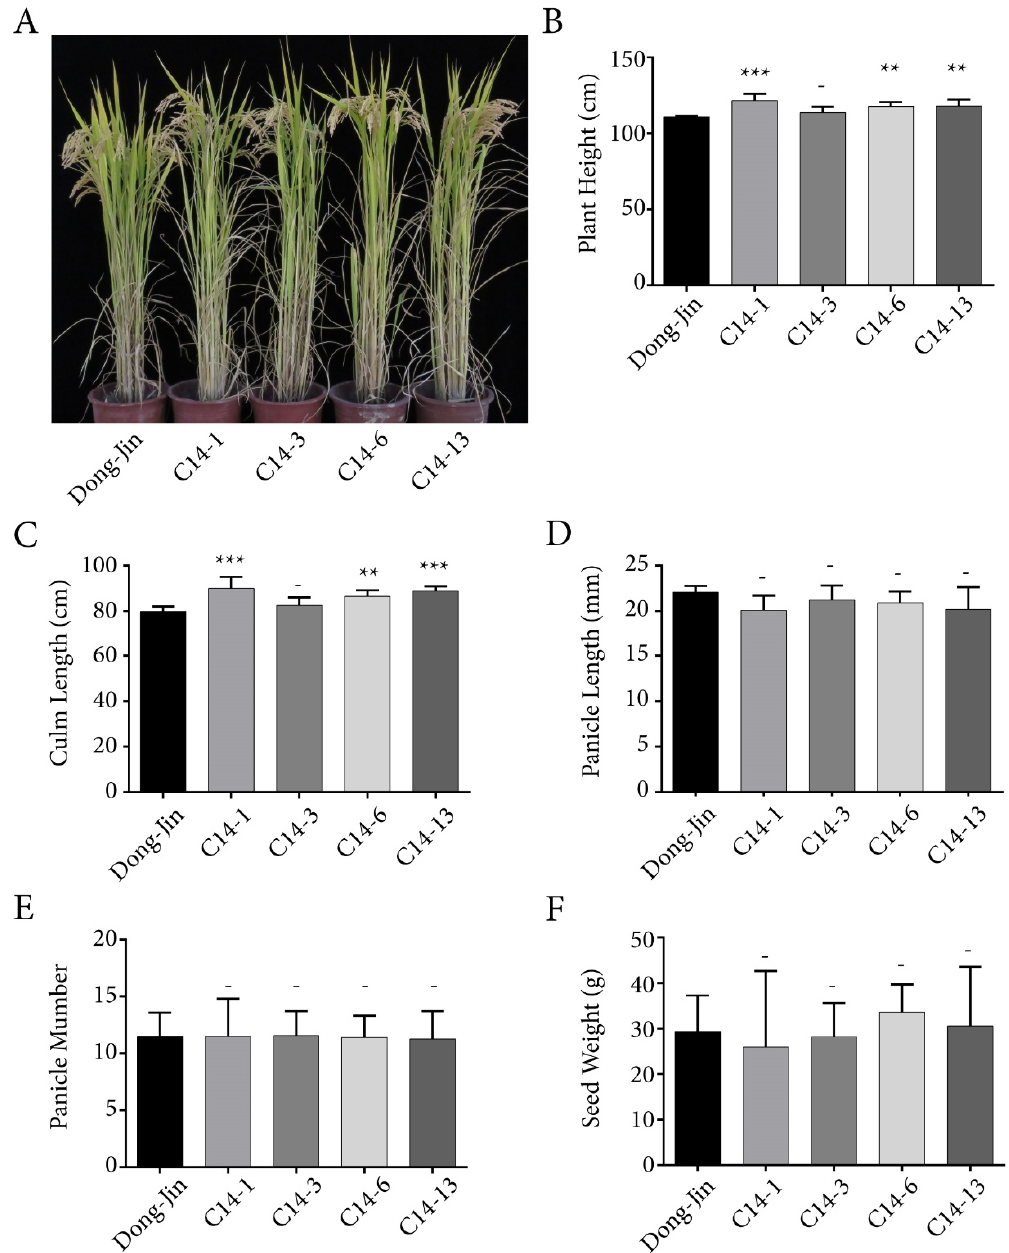
Figure 1. Agricultural traits of rice over-expressing OsPYL / RCAR7 in paddy field. ( A ) Rice plants grown in a paddy field. Image was recorded just before the harvest. ( B – F ) Graphical representation of quantified data of the major agricultural traits of rice productivity. Values represent the average and error bars depict standard deviation. Data were recorded from at least 20 individual plants per line. ** means p -value is less than 0.01. *** means p -value is less than 0.001. – means p -value is higher than 0.05.